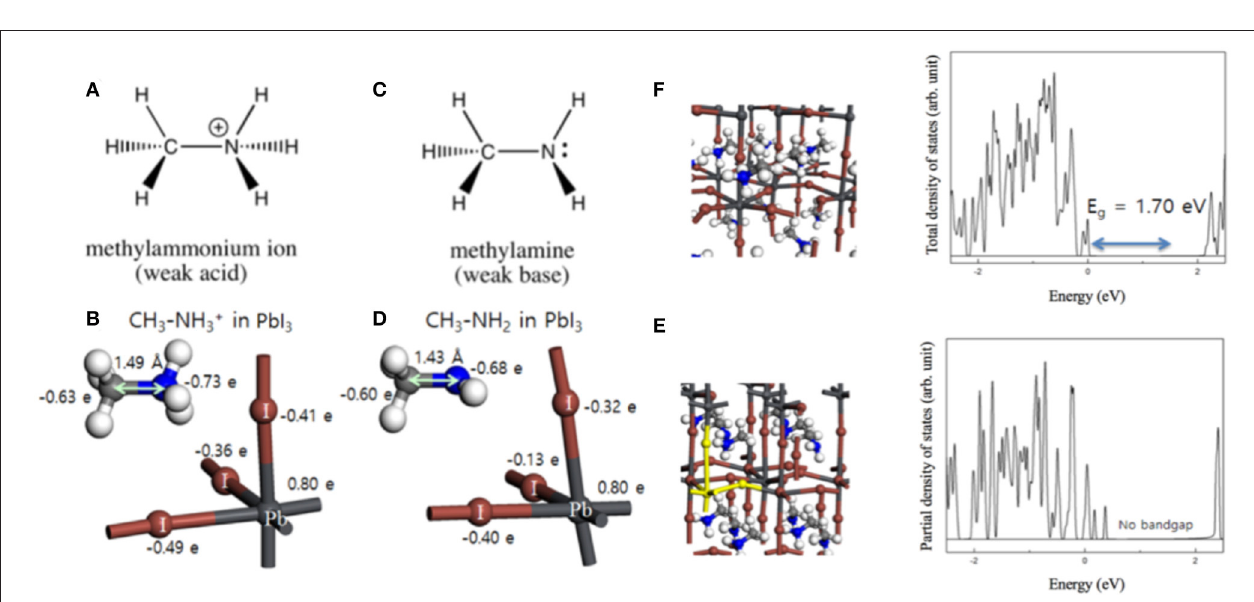
FIGURE 9 | Schematic of (A) charge-carrier and (B) sink at the grain boundary in OHP. [Reprinted with permission from Herz (2017) and Shan and Saidi (2017)].